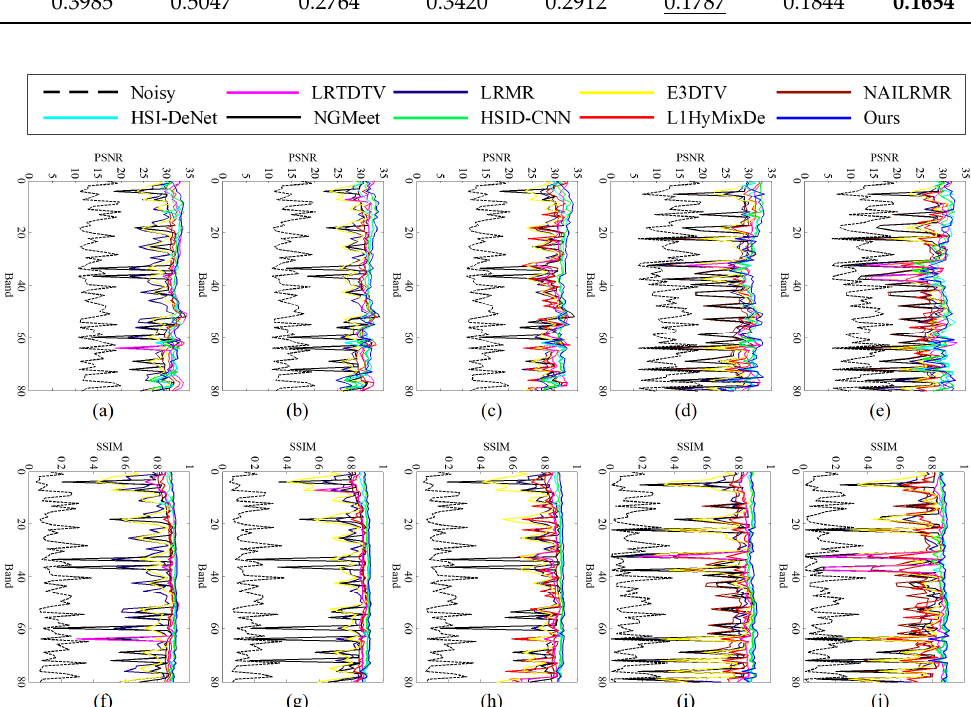
Figure 9. Band-wise PSNR values in the first row and band-wise SSIM values in the second row for denoised Pavia Center data. Subfigures in ( a , f ), ( b , g ), ( c , h ), ( d , i ) and ( e , j ) correspond to Case 1, Case 2, Case 3, Case 4 and Case 5, respectively.